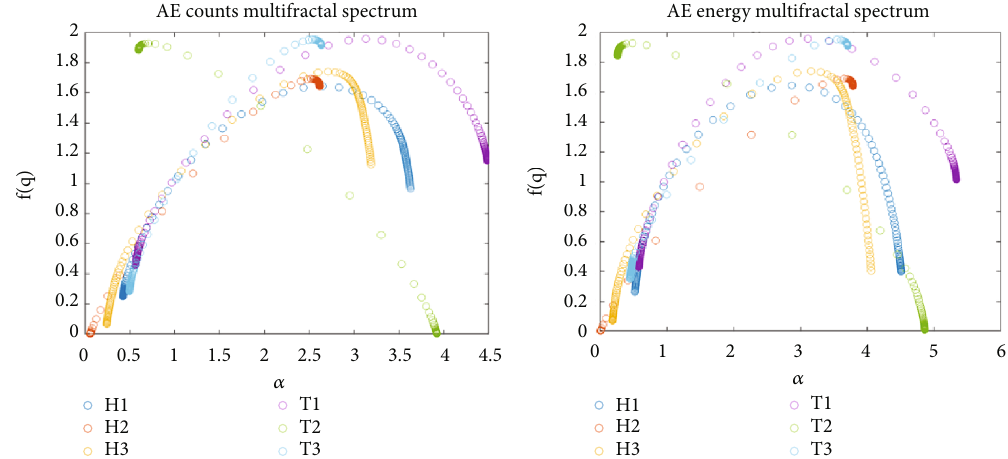
Figure 6: The multifractal spectrum f ð α Þ − α of time series of AE counts and energy for all the stages.